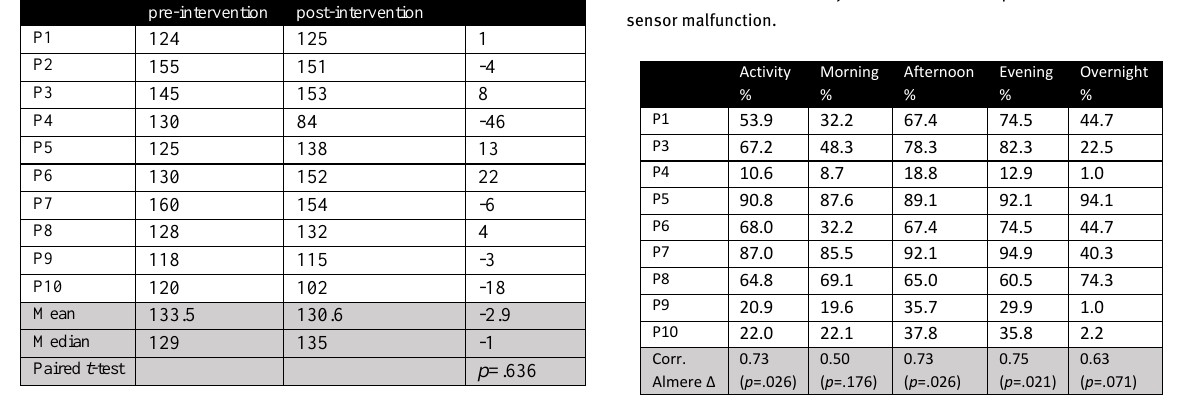
Table 2: The Almere measures attitude toward, and intention to use, a given robot. Higher scores represent more positive attitudes and greater intention to use. Each question is awarded 1-5 points, depending on respondent’s answers to a 5-point Likert scale (from “totally disagree” to “totally agree”, with a 3 representing a “don’t know” option). The maximum possible score in our modified version is 185.